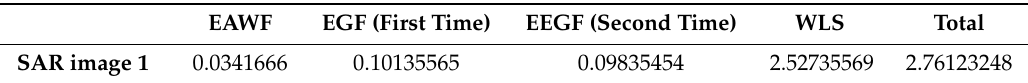
Table 15. Computational complexity results of all the filters in the proposed method for the real SAR image 1 (512 × 512);.